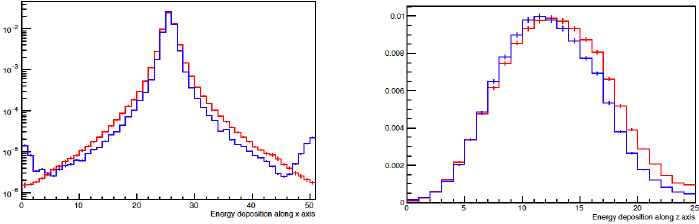
Figure 7. Calorimeter energy response as predicted by 64 GPUs GAN (blue) and Monte Carlo (red). (left) Distribution along the detector transverse plane in logarithmic scale.(right) Distribution along the calorimeter depth in linear